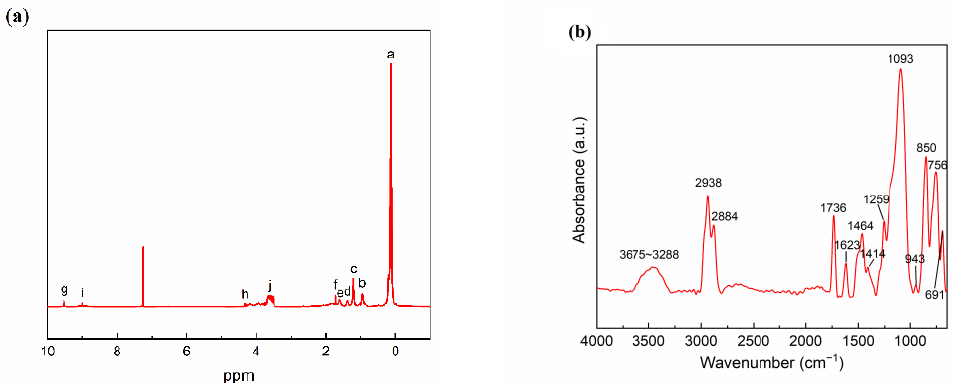
Figure 2. ( a ) the 1 H-NMR spectra of the copolymer; ( b ) the FT-IR spectra of the copolymer.